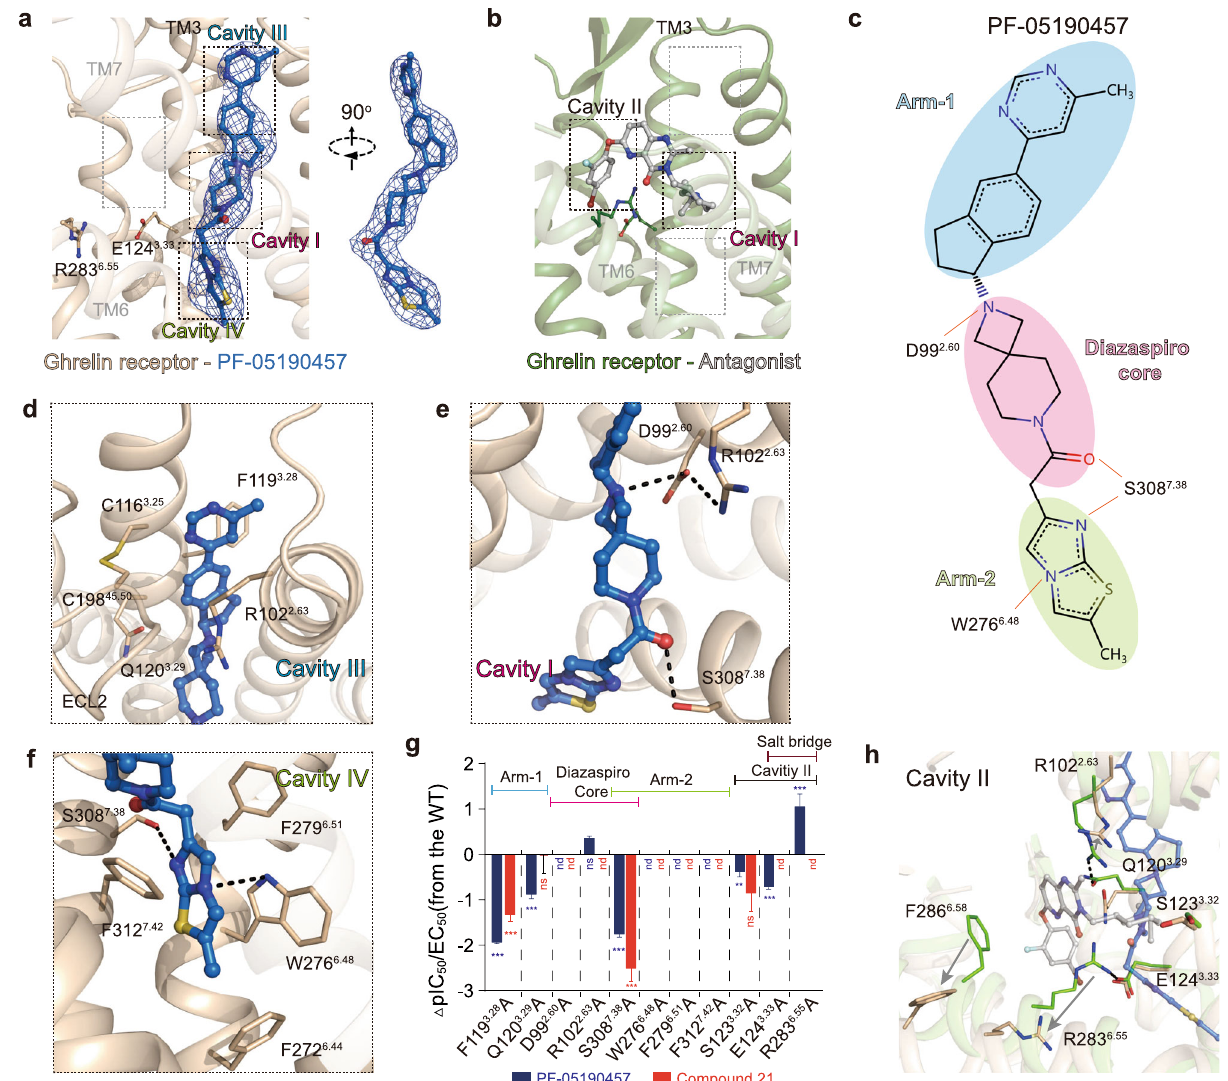
Fig. 2 The binding mode of PF-05190457 with the ghrelin receptor. a The detailed binding mode of PF-05190457 in the orthosteric pocket of the ghrelin receptor. The |Fo| − |Fc| omit map (contoured at 3.0 σ ) for PF-05190457 (shown as marine blue sticks). In particular, the herein described cavities of the ghrelin receptor named cavity III and cavity IV. b The structure of the neutral antagonist (gray stick)-bound ghrelin receptor (forest cartoon) (PDB: 6KO5) reveals a bifurcated ligand-binding pocket, which is referred to as cavities I and II. c Two-dimensional structures of the inverse agonist PF-05190457 and the groups of ligands are termed the diazaspiro core, arm-1 and arm-2. The diazaspiro core is shown in pink, arm-1 is sky blue, and arm-2 is light green. The red solid lines indicate hydrogen bonds involved in interactions with the side chains of key residues. d – f Key residues of the ghrelin receptor (wheat sticks) involved in ligand binding in cavity III ( d ), cavity I ( e ), and cavity IV ( f ). The binding pocket is highly hydrophobic, and the particular polar network is shown as black dotted lines. g IP1 accumulation induced by the inverse agonist PF-05190457 and antagonist compound 21. Bars represent the difference in the calculated potency (pIC 50 ) of the inverse agonist for mutations relative to the WT ghrelin receptor. Data are colored according to extent of effect. nd not detected, ** P < 0.01, *** P < 0.001 (one-way analysis of variance (ANOVA) followed by Dunnett ’ s test, compared with the response of WT, P < 0.001, P < 0.001, P < 0.001, P > 0.999, nd, nd, P = 0.05, nd, P < 0.001, P < 0.001, nd, nd, nd, nd, nd, nd, P < 0.01, P = 0.264, P < 0.001, nd, P < 0.001, nd from left to right). Data represent the mean ± SEM from n = 3 biologically independent experiments performed in triplicate. See also Supplementary Figs. 6 and 7. h Structural superimposition of inverse agonist-bound with neutral antagonist-bound structures shows signi fi cant displacements of the critical residues in the orthosteric pocket. The salt bridges between E124 3.33 and R283 6.55 as well as between R102 2.63 and Q120 3.29 , are broken upon PF-05190457